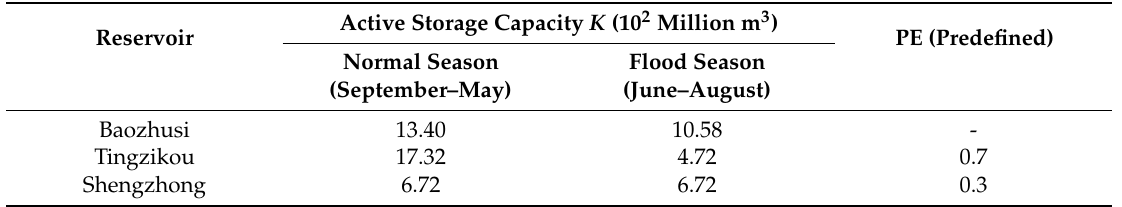
Table 2. Reservoir characteristic parameters.